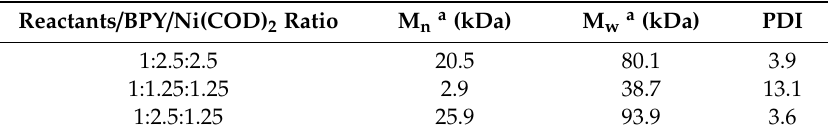
Table 4. Catalyst ratio and molecular weight distribution of the